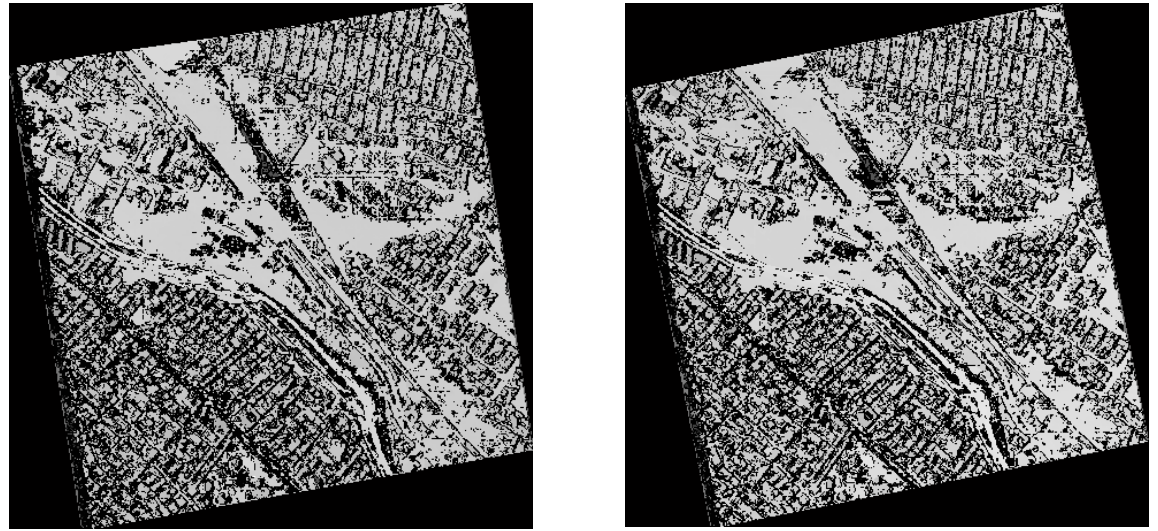
Figure 8. Disparity map computed by SGM algorithm for epipolar images produced by fundamental matrix (left) and Morgan’s method (right)